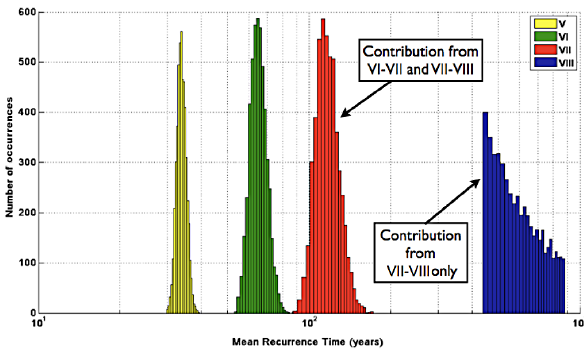
Figure 2. Histograms of the MRT in Ferrara, produced by 5000 runs for some of the intensity classes.